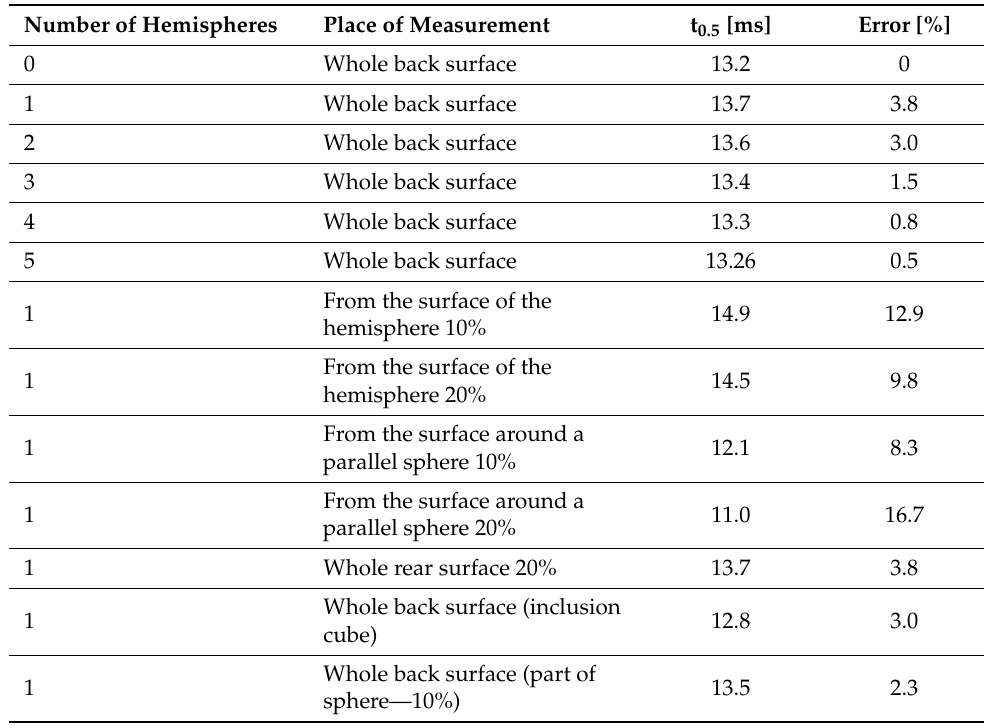
Table 3. Half-life and error of its determination for different configurations of the tested